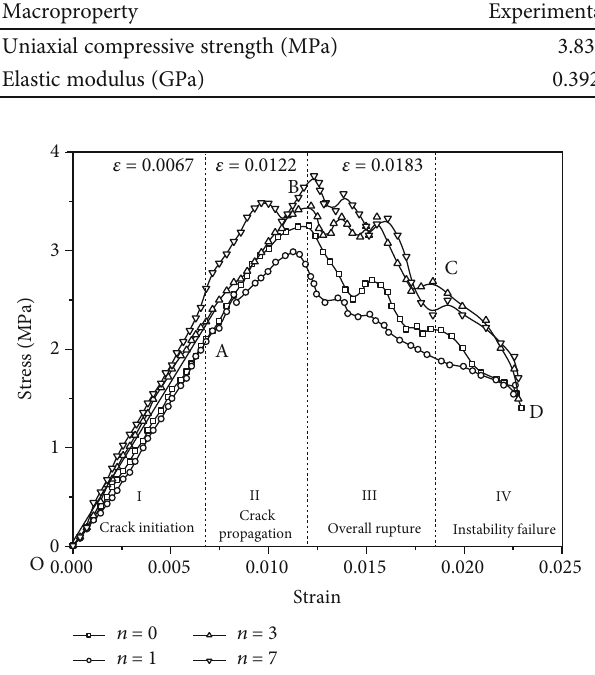
Figure 3: Uniaxial compressive stress-strain curve of specimen with bent cracks at di ff erent bend numbers.